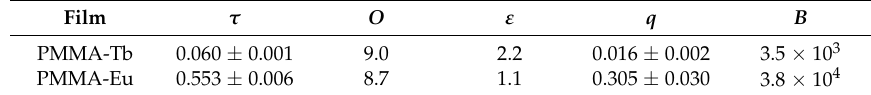
Table 1. 5 D 4 (PMMA-Tb) and 5 D 0 (PMMA-Eu) lifetime values ( τ , × 10 − 3 s), integral